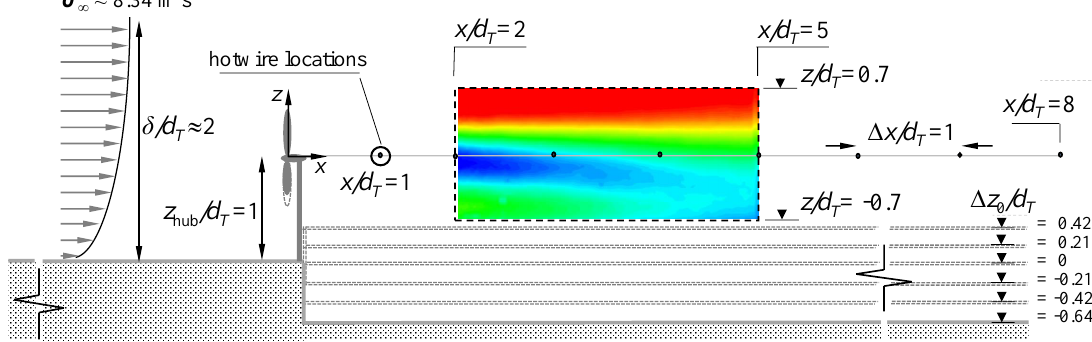
Figure 1. Basic schematic of the experimental setup illustrating the topographic forward- and backward-facing steps, PIV field of view and locations of the complementary hotwire measurements.